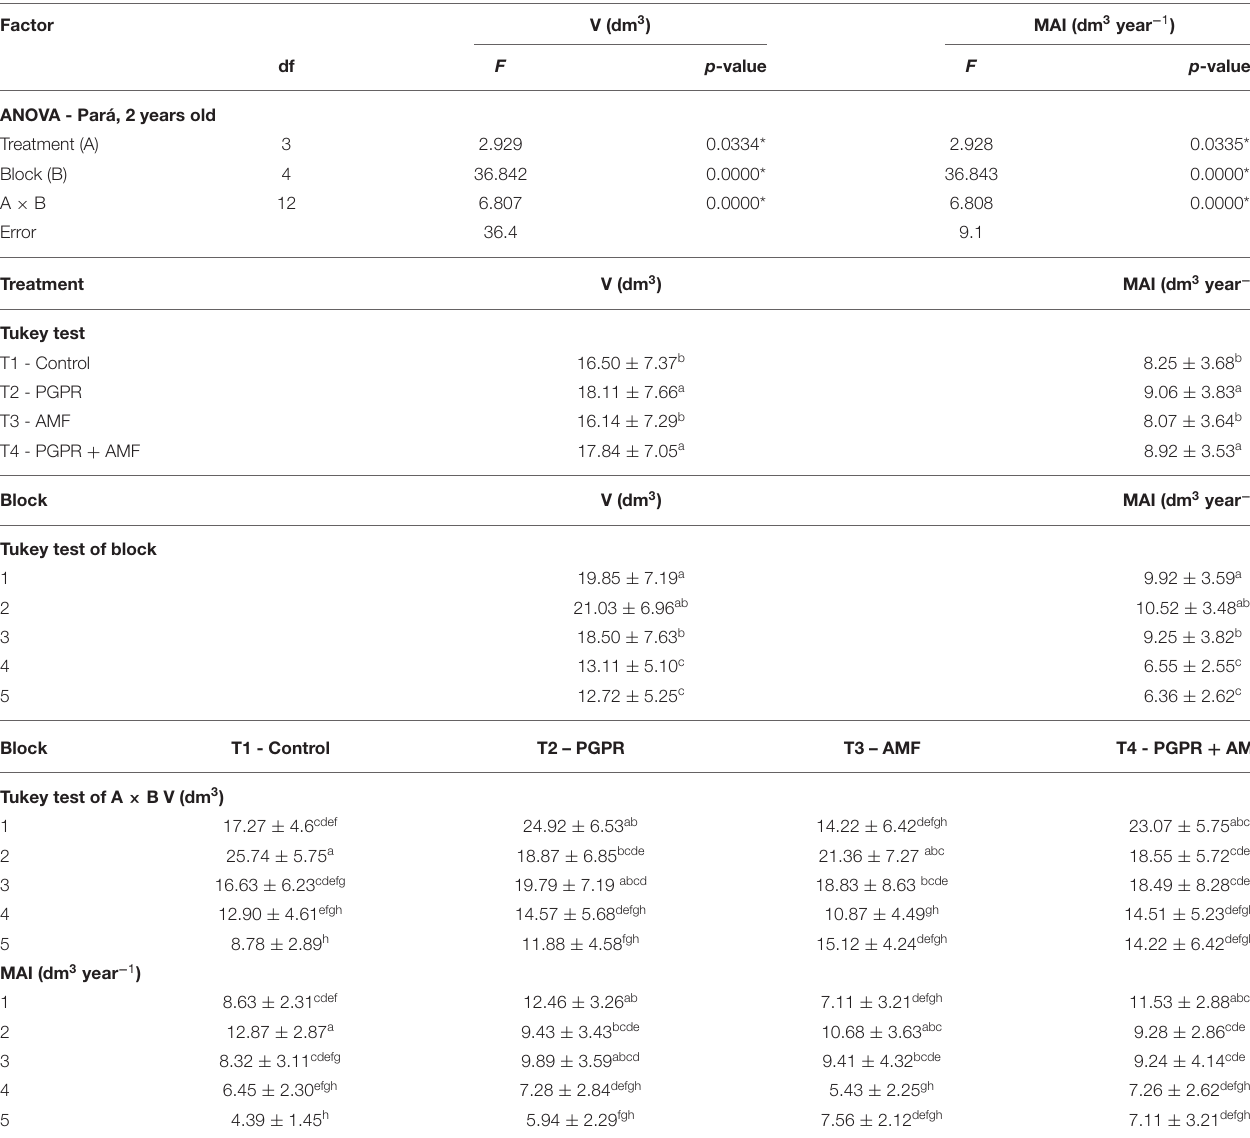
TABLE 8 | Tree volume and mean annual increment at 2 years old in plants of Tectona grandis in Pará state, Brazil.